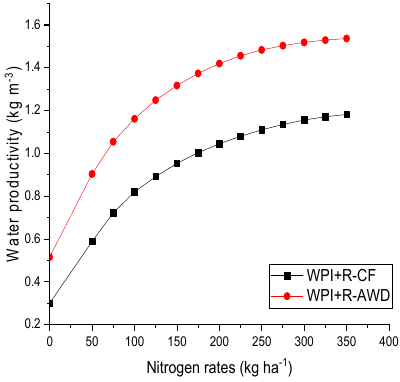
Figure 8. Simulated different nitrogen efficiencies and applied fertilizer N, with AWD and CF conditions. Each value is the average of 45 years between 1961 and 2005.